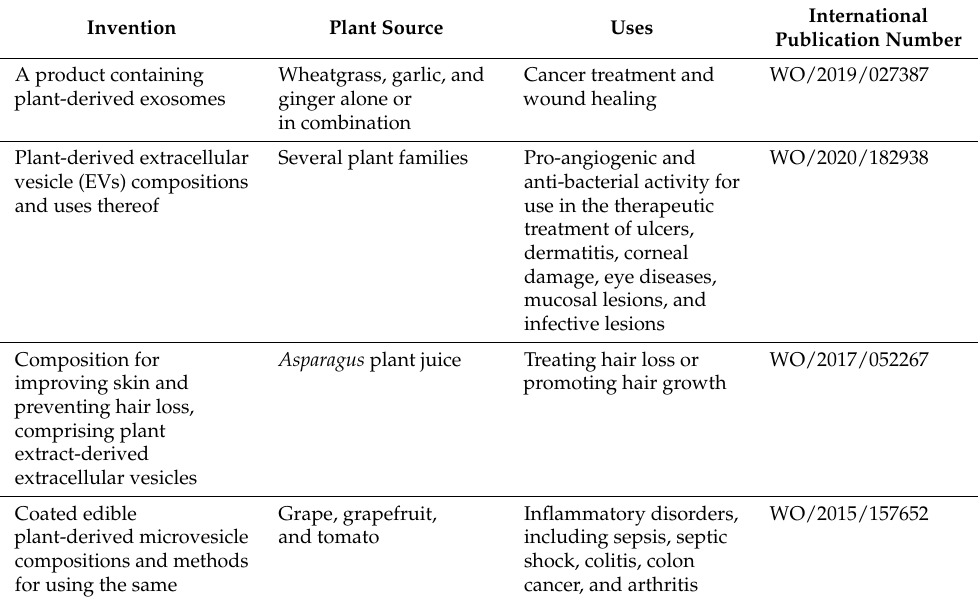
Table 1. Patented plant nanovesicles for therapeutic